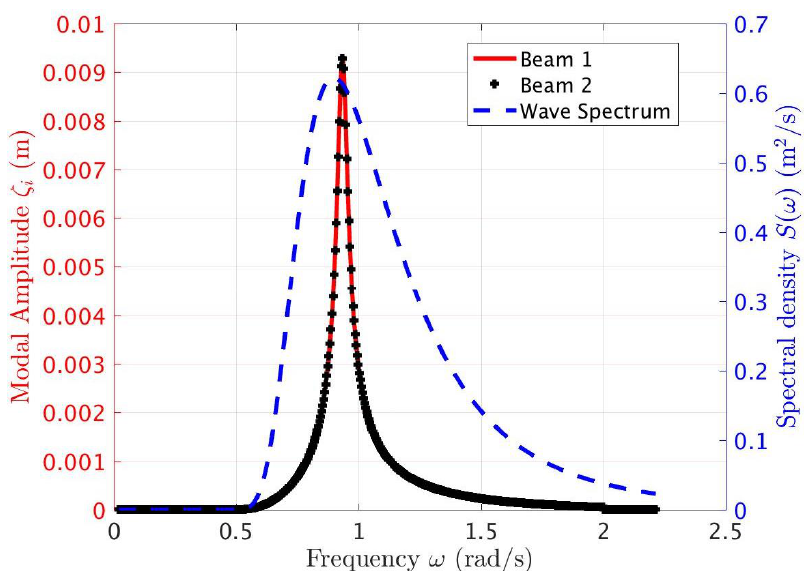
Figure 10. Fundamental modes of beam flexural deflection amplitude response to an irregular wave spectrum (Pierson–Moskowitz, H s = 1.0 m, T e = 5.0 s) with beams fitting loosely within their deck supports. Also shown is the power spectral